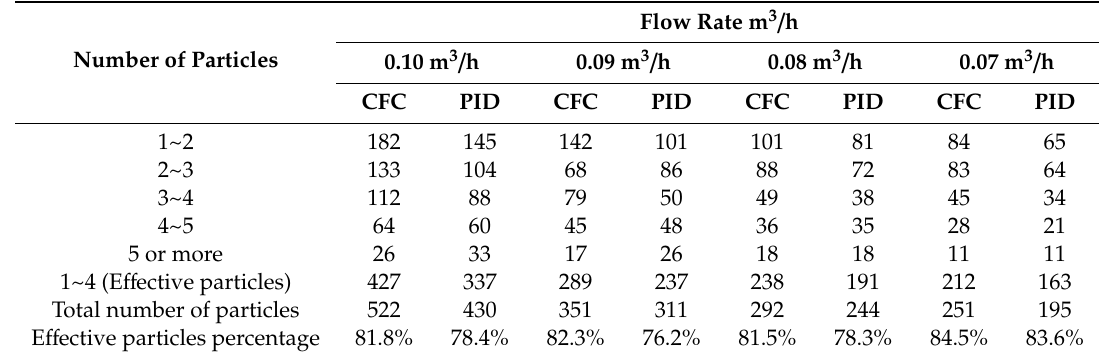
Table 4. Spray conditions at various flow rates at the pressure of app. 0.5 MPa.